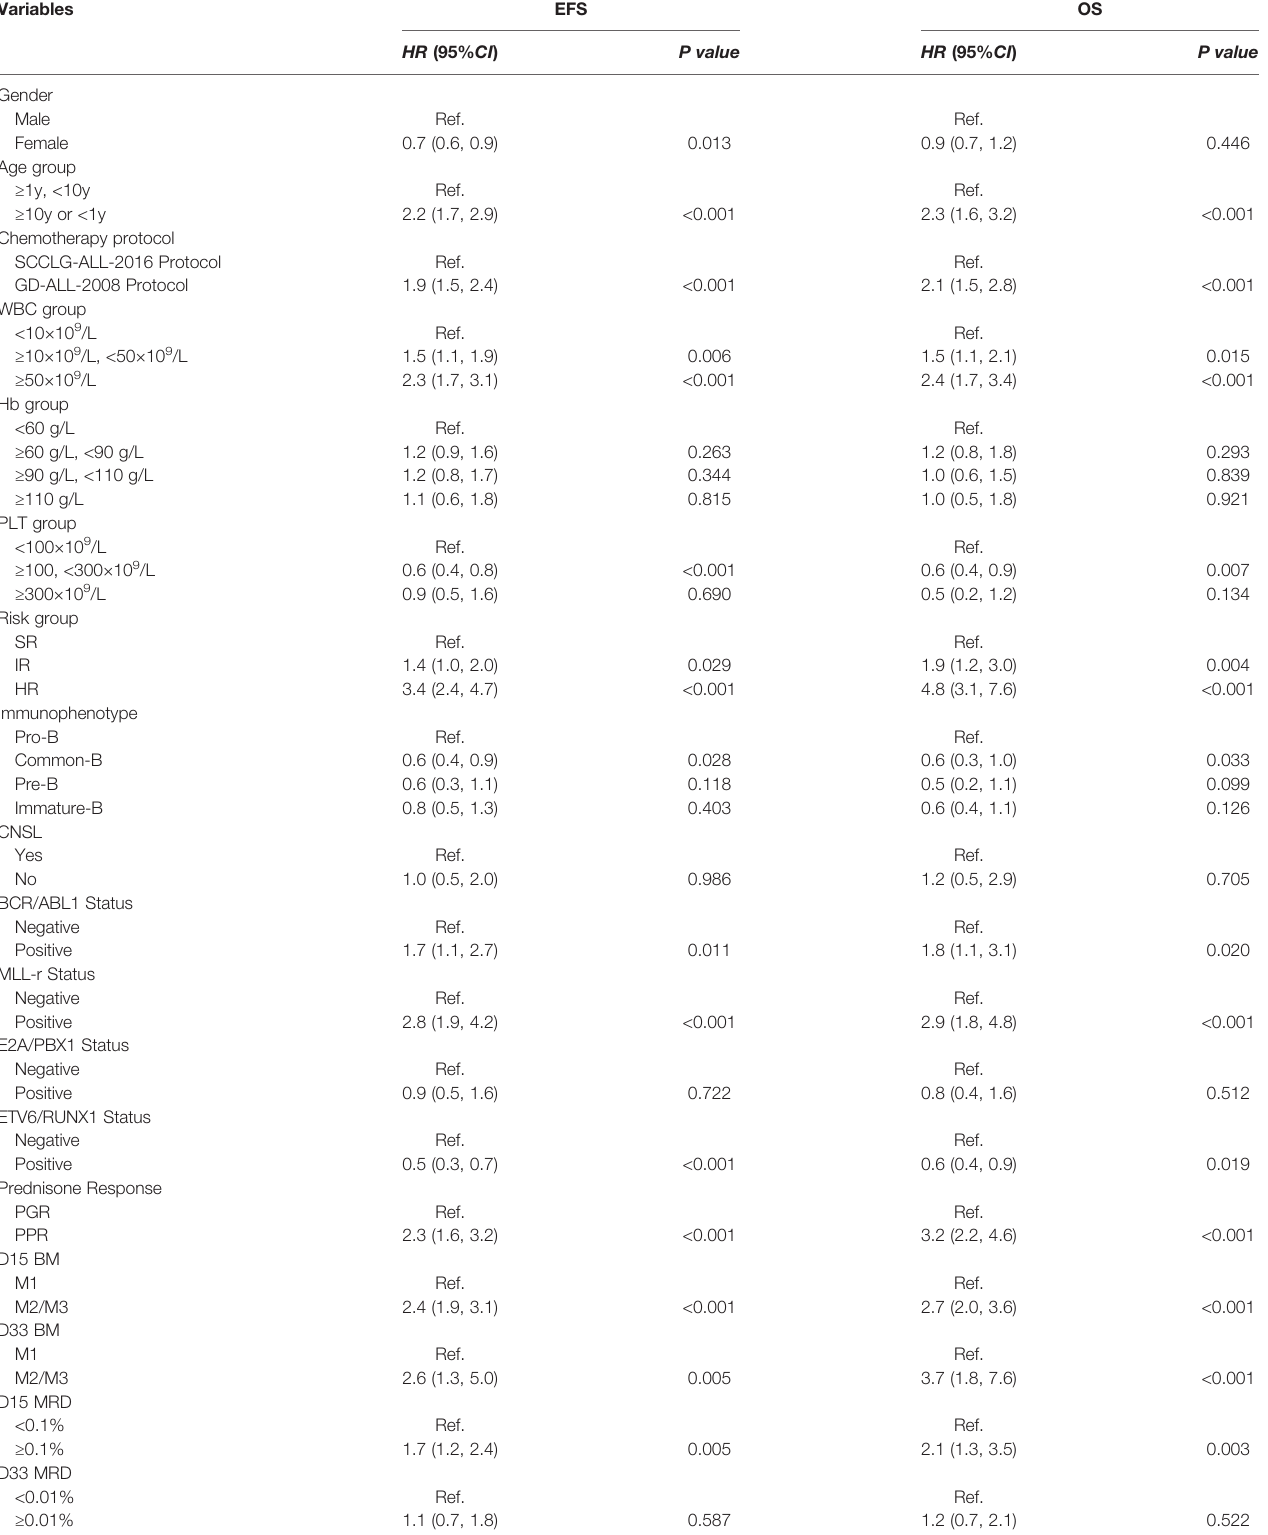
TABLE 2 | Univariate and analysis for EFS and OS among pediatric patients with